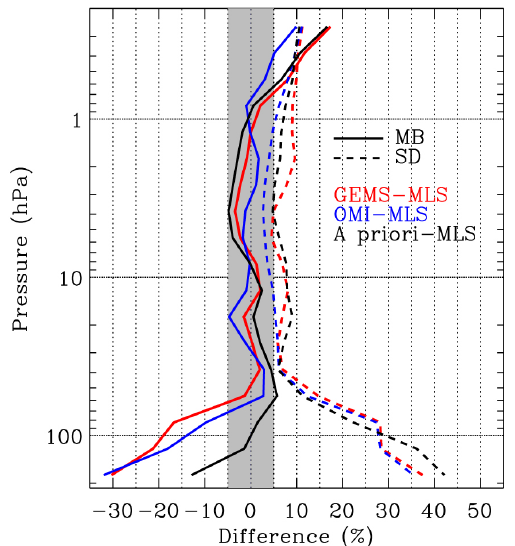
Fig. 4. Mean biases and 1 σ standard deviations calculated using all the collocated profiles globally for April 2006.